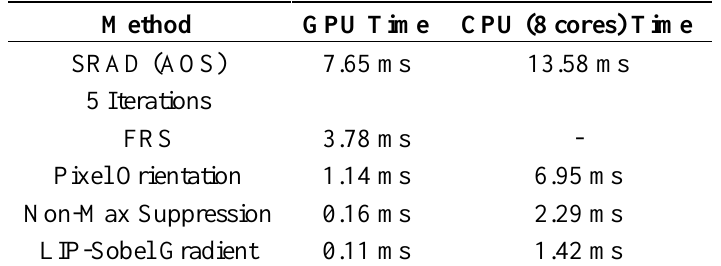
Table 1. Computation time evaluation of the main methods used in the proposed algorithm on the graphics processing unit (GPU) and parallel CPU implementation. AOS, additive operator splitting; FRS, fast radial